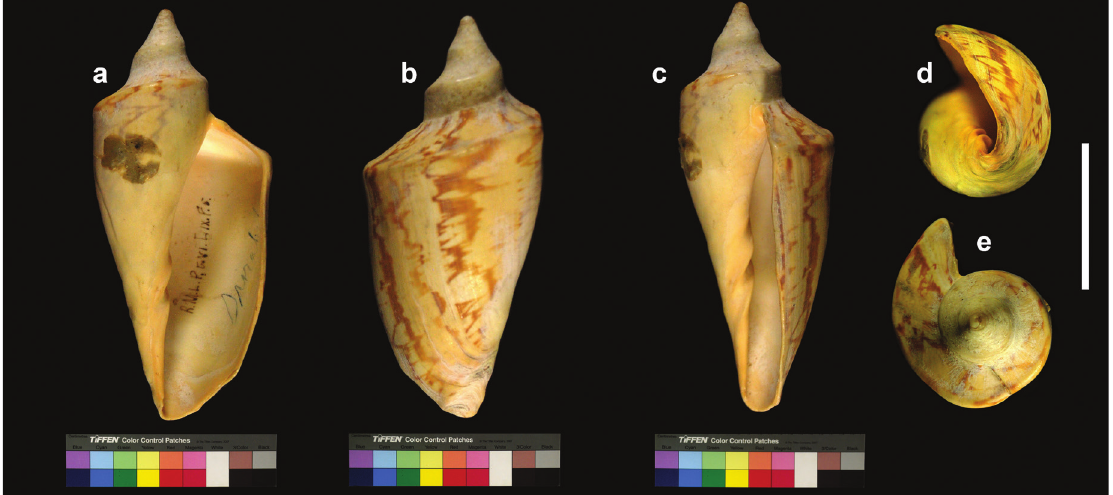
Figure 23. Voluta angulata similis , specimen figured by Lahille (1895: pl. IX, fig. 5). a Apertural view b Dorsal view c Lateral view d Umbilical view e Apical view. Scale bar: 5 cm.